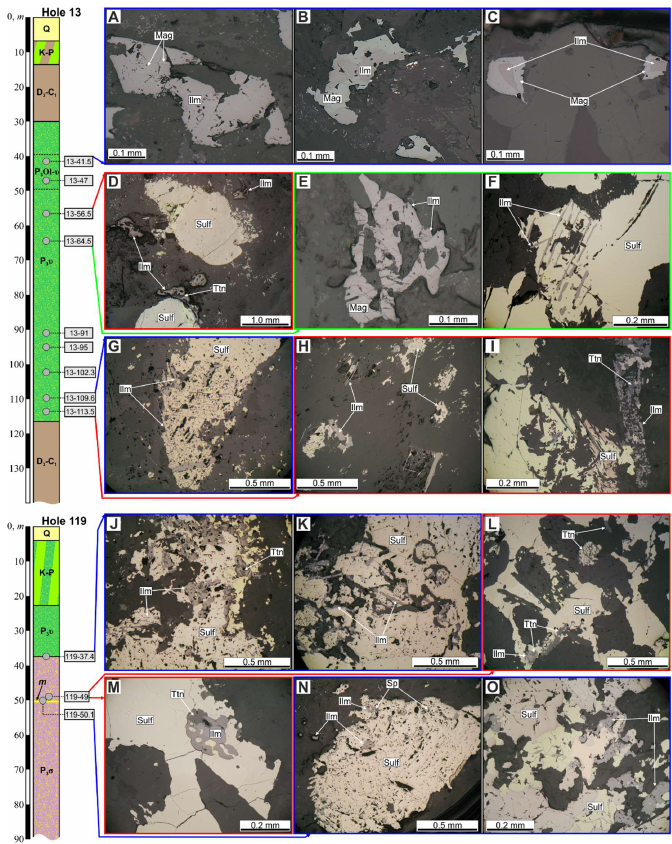
Figure 2. Reflected light microphotographs illustrating morphology and textures of ilmenite from the metamorphosed mafic-ultramafic rocks of the Sedova Zaimka intrusion. Lithological columns for boreholes 13 and 119 showing the sampling sites are also given. ( A – C ) Ilmenite dissemination in olivine metagabbro from Borehole 13 (sample 13-41.5): (A) ilmenite with exsolved lamellae of magnetite; (B) ilmenite-magnetite intergrowths; (C) grains with ilmenite cores and magnetite rims. (D–I) Ilmenite in meta-mafic unit from Borehole 13: ( D ) ilmenite represented by independent grains in rock matrix and a partial rim around sulfides (sample 13-56.5); ( E ) an anhedral magnetite–ilmenite grain in rock matrix which contains laths of ilmenite in magnetite (sample 13-64.5); ( F ) ilmenite relicts in sulfides (sample 13-64.5); ( G ) ilmenite relicts in sulfides (sample 13-109.6); ( H ) ilmenite relicts in rock matrix in association with sulfides (sample 13-109.6); ( I ) ilmenite relicts in rock matrix in association with sulfides; ilmenite is replaced by titanite (sample 13-113.5). ( J – O ) Ilmenite in meta-